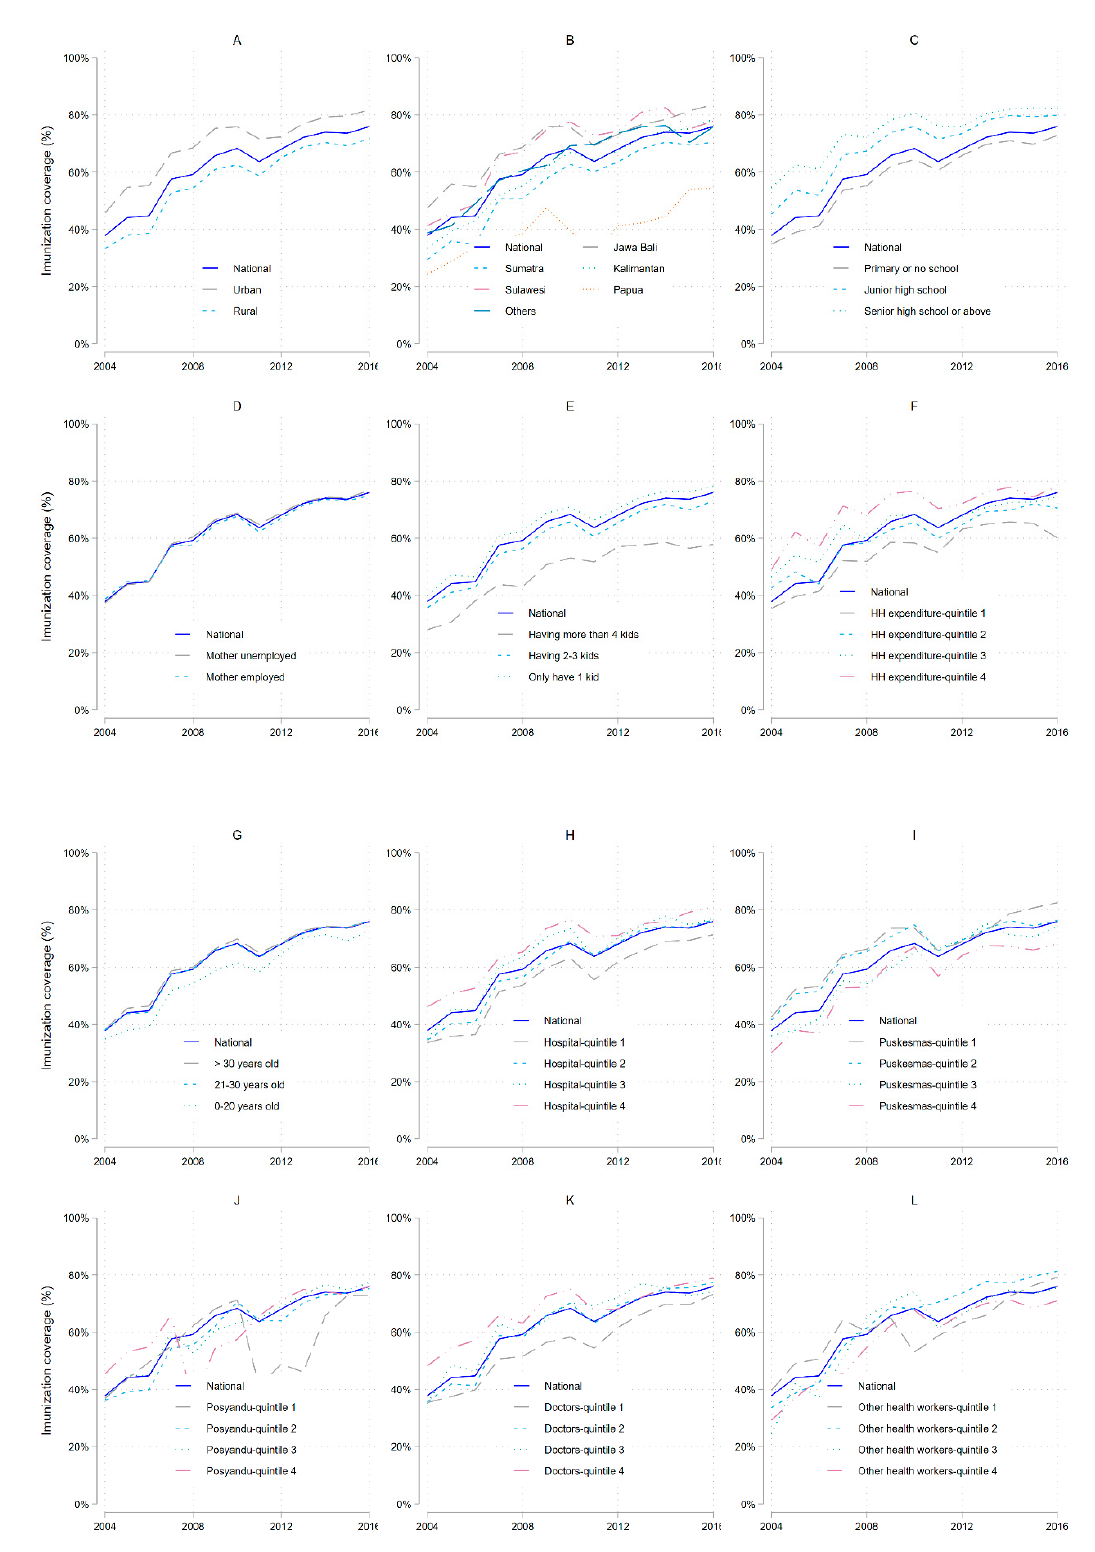
Figure 1. DTP3 immunization coverage by ( A ) residential area; ( B ) residential island; ( C ) mother’s education; ( D ) mother’s employment; ( E ) number of children; ( F ) household expenditure (in quintiles); ( G ) mother’s age; ( H ) density of hospitals (in quintiles); ( I ) density of puskesmas (in quintiles); ( J ) density of posyandu (in quintiles); ( K ) density of doctors (in quintiles); ( L ) density of other health workers (in quintiles).